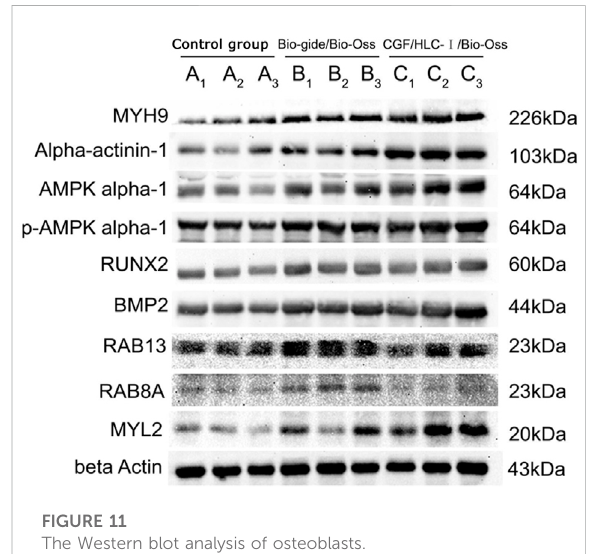
FIGURE 11 The Western blot analysis of